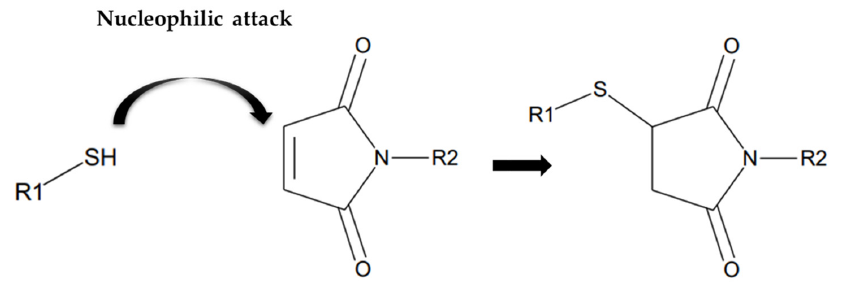
Figure 1. Scheme of Michael addition reaction between free sul fh ydryl group and maleimide